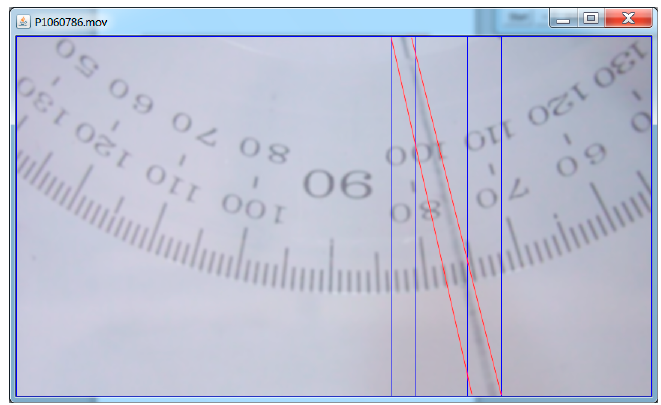
Figure 11. Experimental measurement of the angular amplitude of the pendulum.